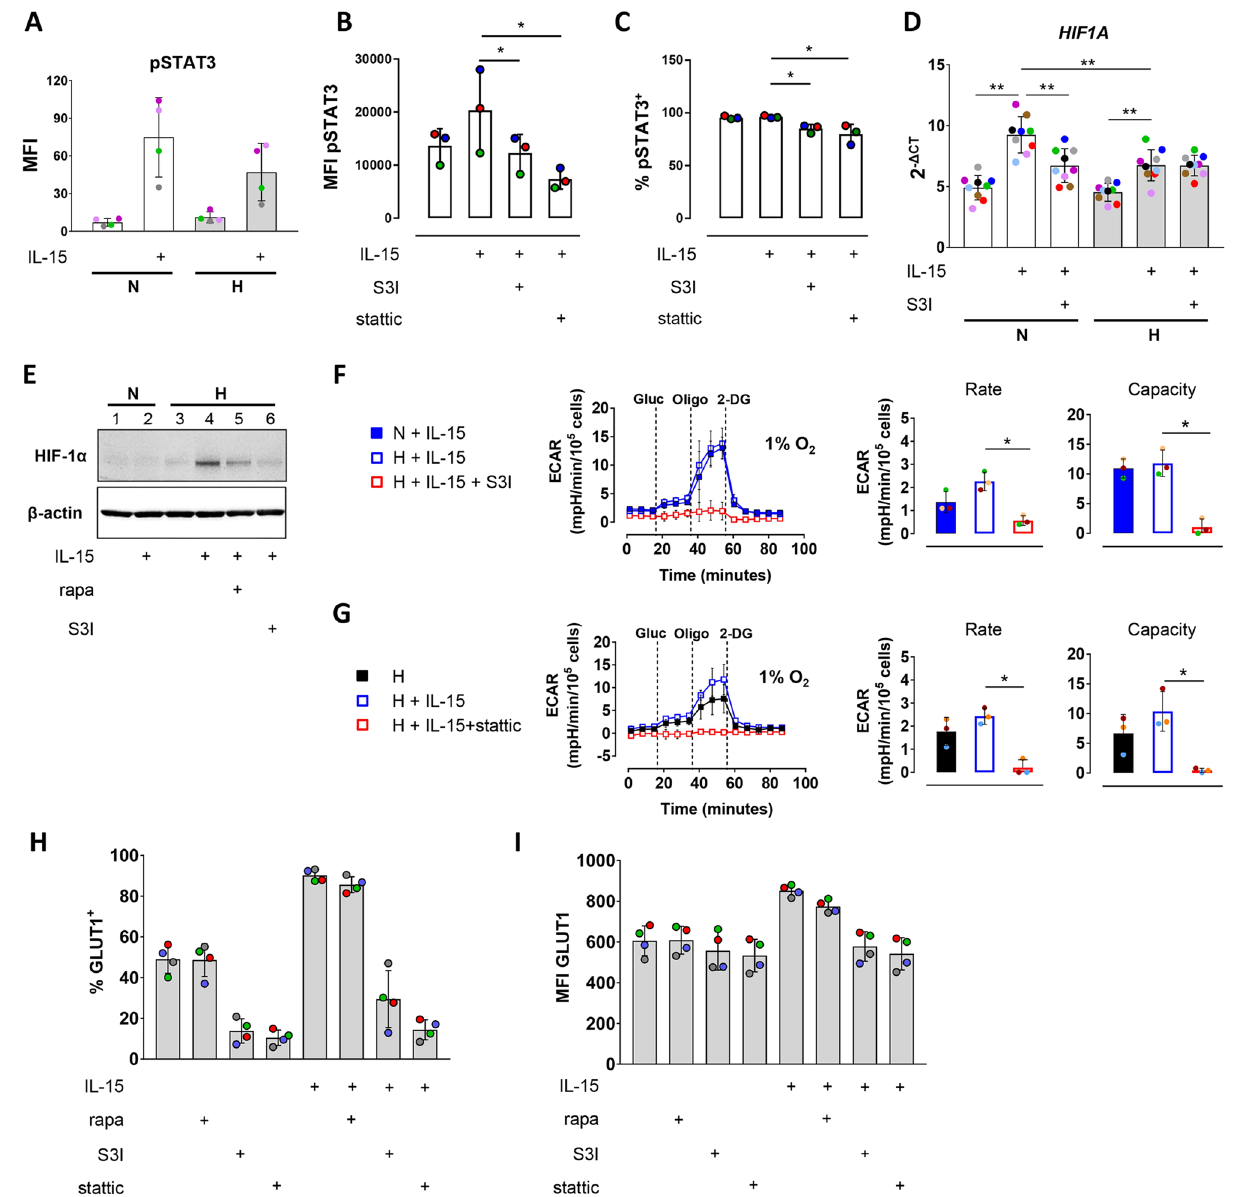
Figure 3. IL-15 priming induced HIF-1α accumulation and glycolysis in NK cells depend on STAT3. ( A – I ) NK cells were incubated under normoxia (N) or hypoxia (H) for 16 h and primed with IL-15 for additional 6 h in the presence or absence of STAT3 inhibitors (S3I-201, stattic) or rapamycin (rapa) as indicated. ( A ) Bead array analysis of pSTAT3 Ser727 . Mean values ± SD of median fluorescence intensities (MFI) are shown (n = 4). The level of statistical significance was not reached when applying the Wilcoxon signed-rank test. ( B ) and ( C ) Flow cytometric data for the proportions of ( B ) pSTAT3 Ser727 MFI and ( C ) the proportion of pSTAT3 + NK cells, shown as mean values ± SD (n = 3). * p < 0.05, Friedman test with Dunn’s test for post-hoc pairwise comparisons. ( D ) HIF1A gene expression analysis by RT-PCR. Linearized quantities (2 −ΔCt ) are represented as mean values ± SD (n = 9). ** p < 0.01, Wilcoxon signed-rank test. ( E ) Immunoblot analysis with antibodies against HIF-1α and β-actin. The blot reflects one representative experiment of three performed. ( F ) and ( G ) Glycolytic parameters. Extracellular acidification rate (ECAR) values were measured over time in a hypoxic chamber at 1% O 2 . Each data point represents an average ± SD of three independent experiments. Dashed lines indicate additions of glucose (Gluc), oligomycin (Oligo), and 2-deoxyglucose (2-DG). * p < 0.05, Friedman test with Dunn’s test for post-hoc pairwise comparisons. ( H ) and ( I ) Flow cytometric data for ( H ) the proportion of GLUT1 + hypoxic NK cells and ( I ) GLUT1 MFI is represented as mean values ± SD (n = 4). The level of statistical significance was not reached when applying the Wilcoxon signed-rank